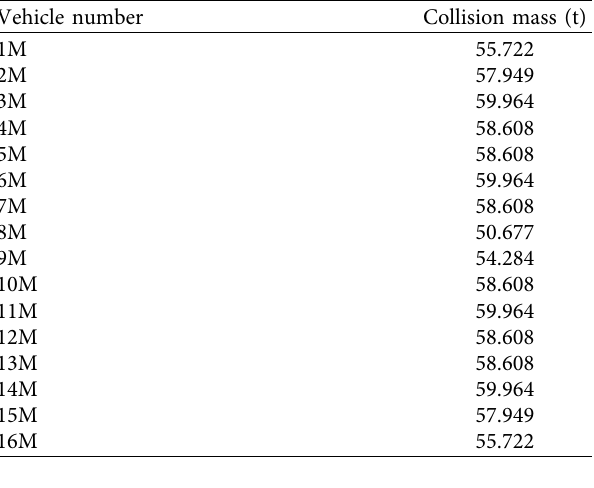
Figure 1: Multistage energy absorption system at end of car body. Table 1: Train marshaling